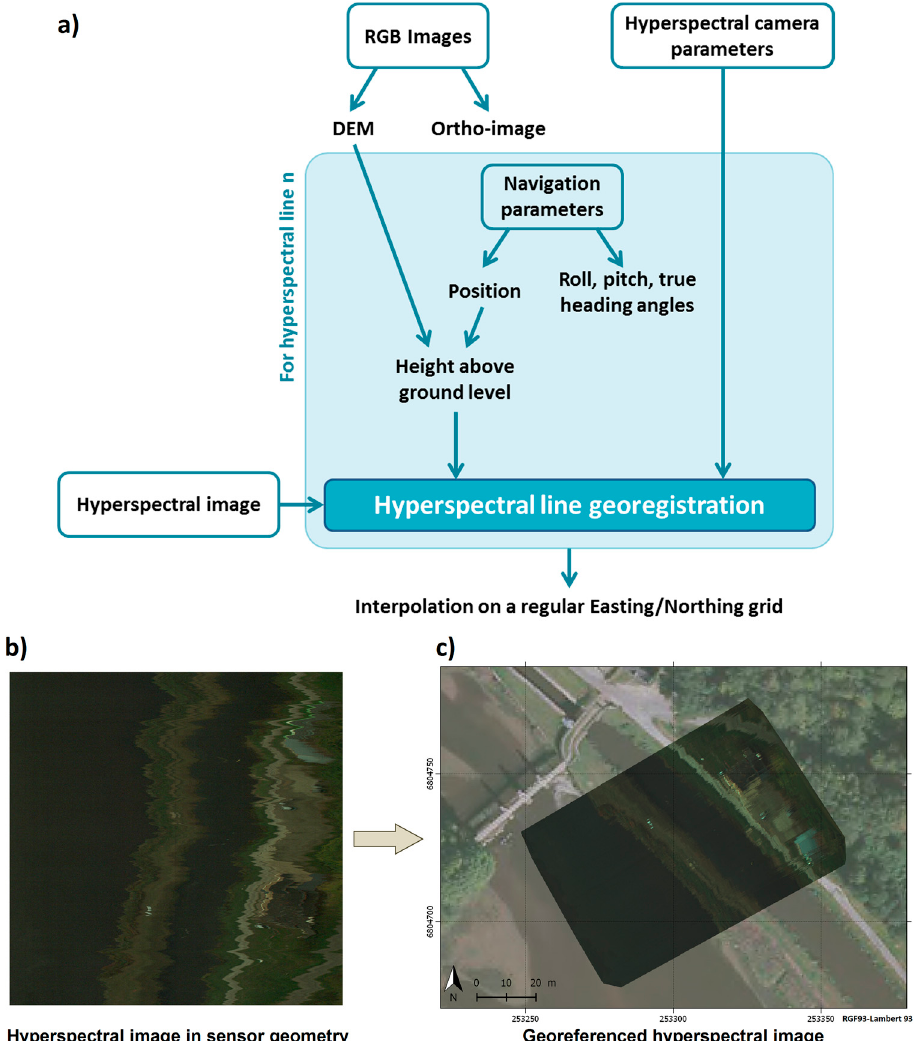
Figure 4. ( a ) Processing chain for hyperspectral lines georegistration. ( b ) Example of hyperspectral image (in natural colors) in sensor geometry and ( c ) of the georeferenced hyperspectral image after line-by-line georectification and georeferencing. DEM: Digital Elevation Model.